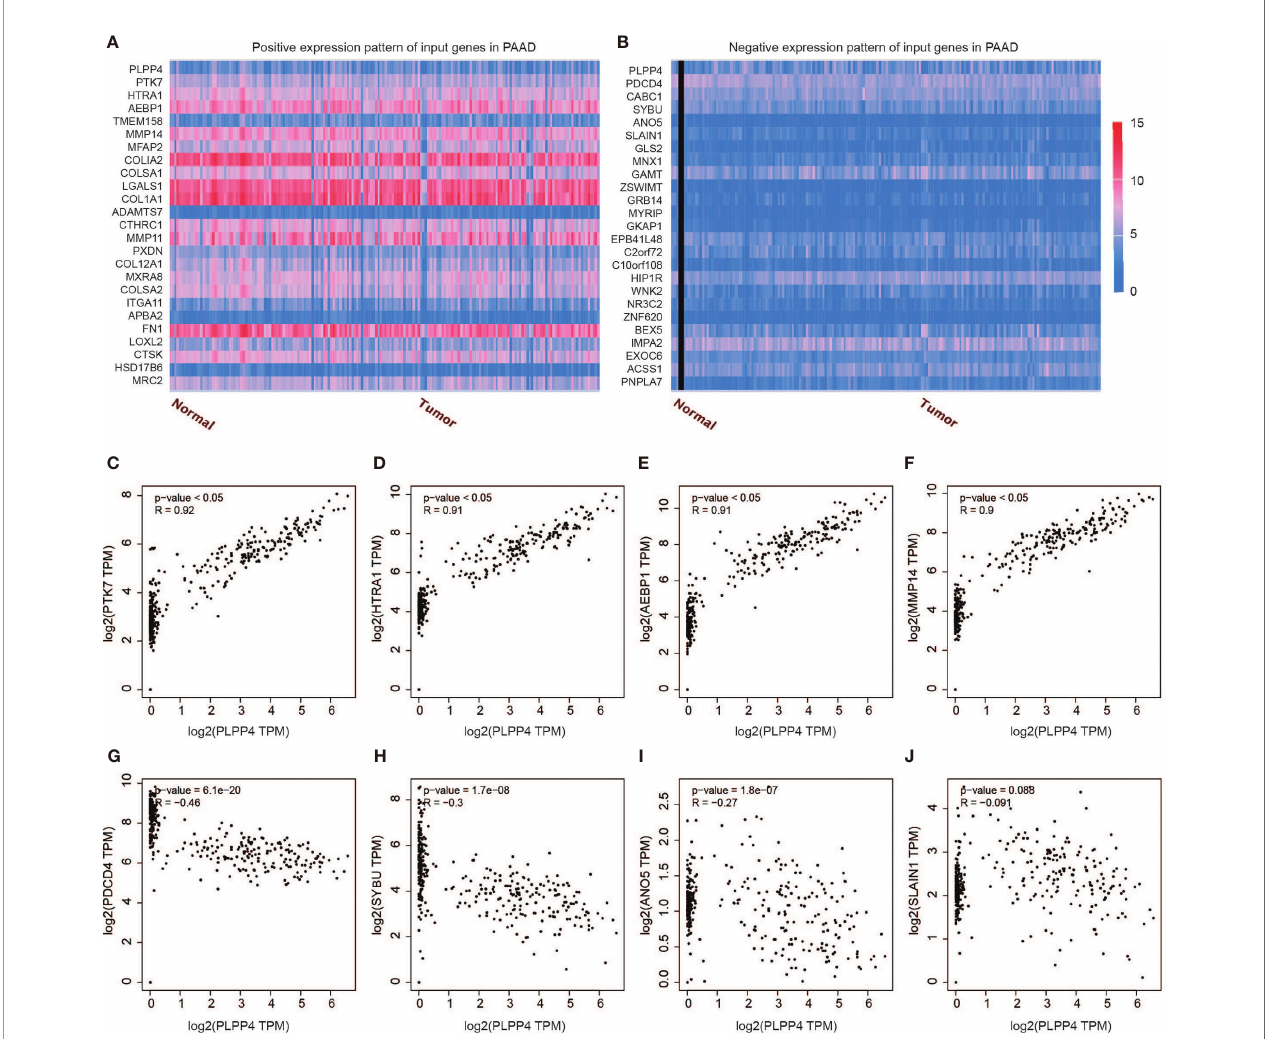
FIGURE 12 | Genes correlated with PLPP4 in PAAD. (A) Genes positively correlated with PLPP4 in PAAD (B) Genes negatively related with PLPP4 in PAAD. (C – F) Positive correlation analysis between PLPP4 and other genes (PTK7, HTRA1, AEBP1, MMP14). (G – J) Negative correlation analysis between PLPP4 and other genes (PDCD4, SYBU, ANO5,